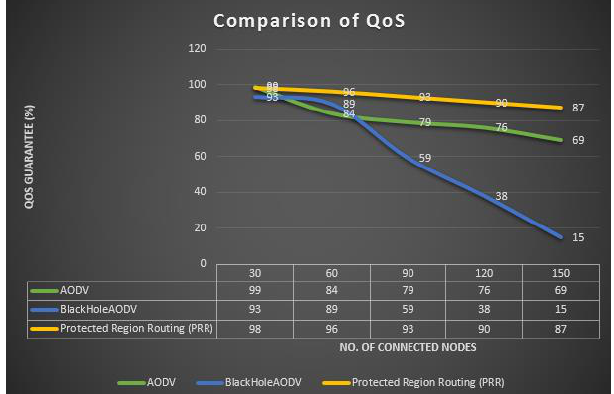
Fig.12. Comparison of